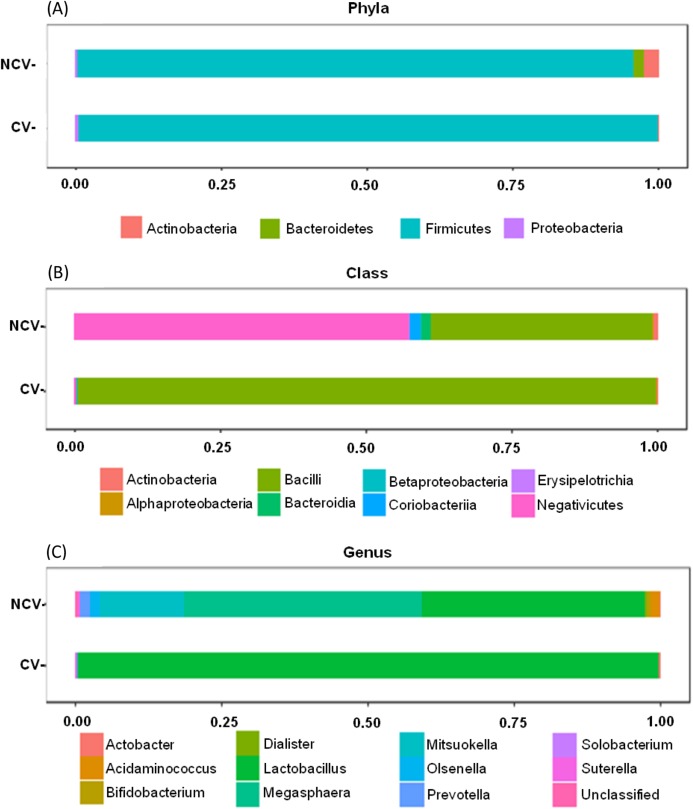
Bar charts of most abundant (A) phyla, (B) classes and (C) genera of non-concentrated vinasse (NCV) concentrated vinasse (CV).